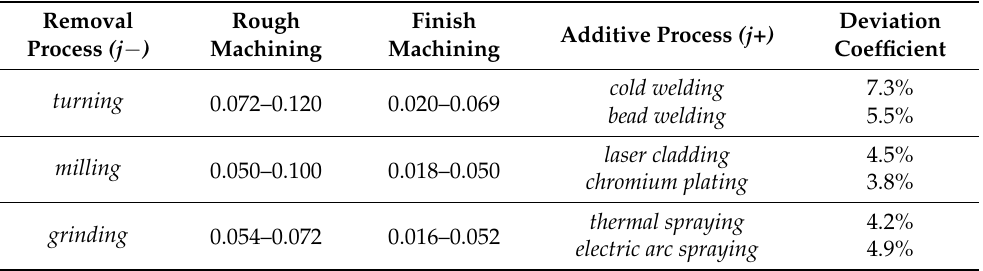
Table 6. Machining capability of each process.